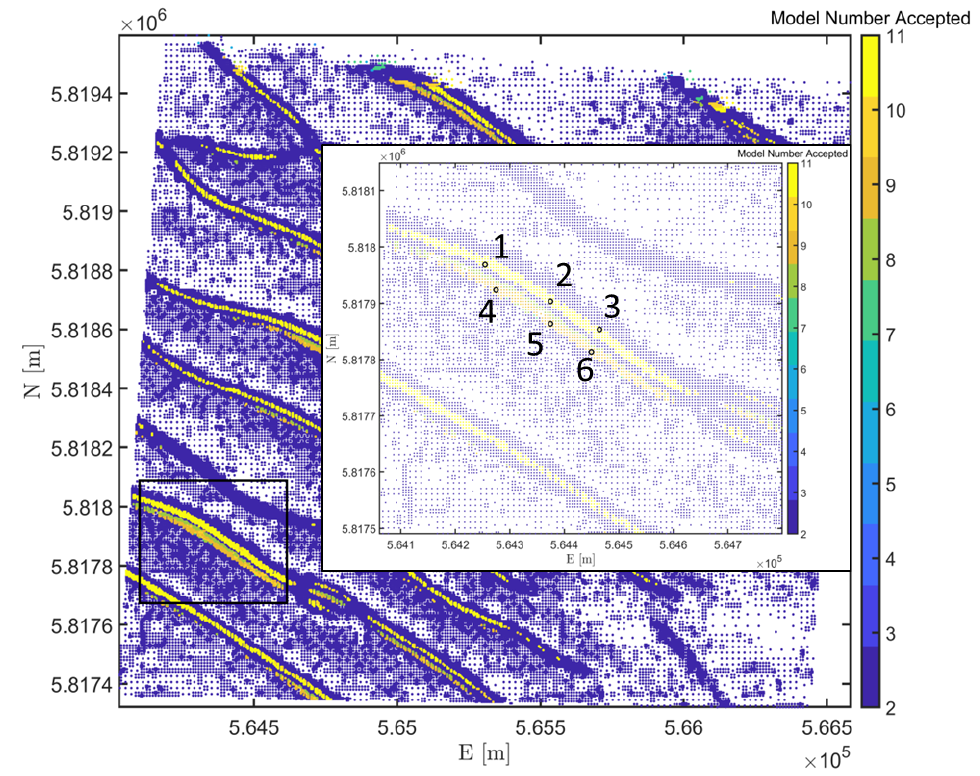
Figure 9. Zoomed-in section of sub-area NF, showing nodes numbered 1–6 where an alternative model (piecewise linear model), M ( s , j ) is accepted in favour of M 2 (constant velocity